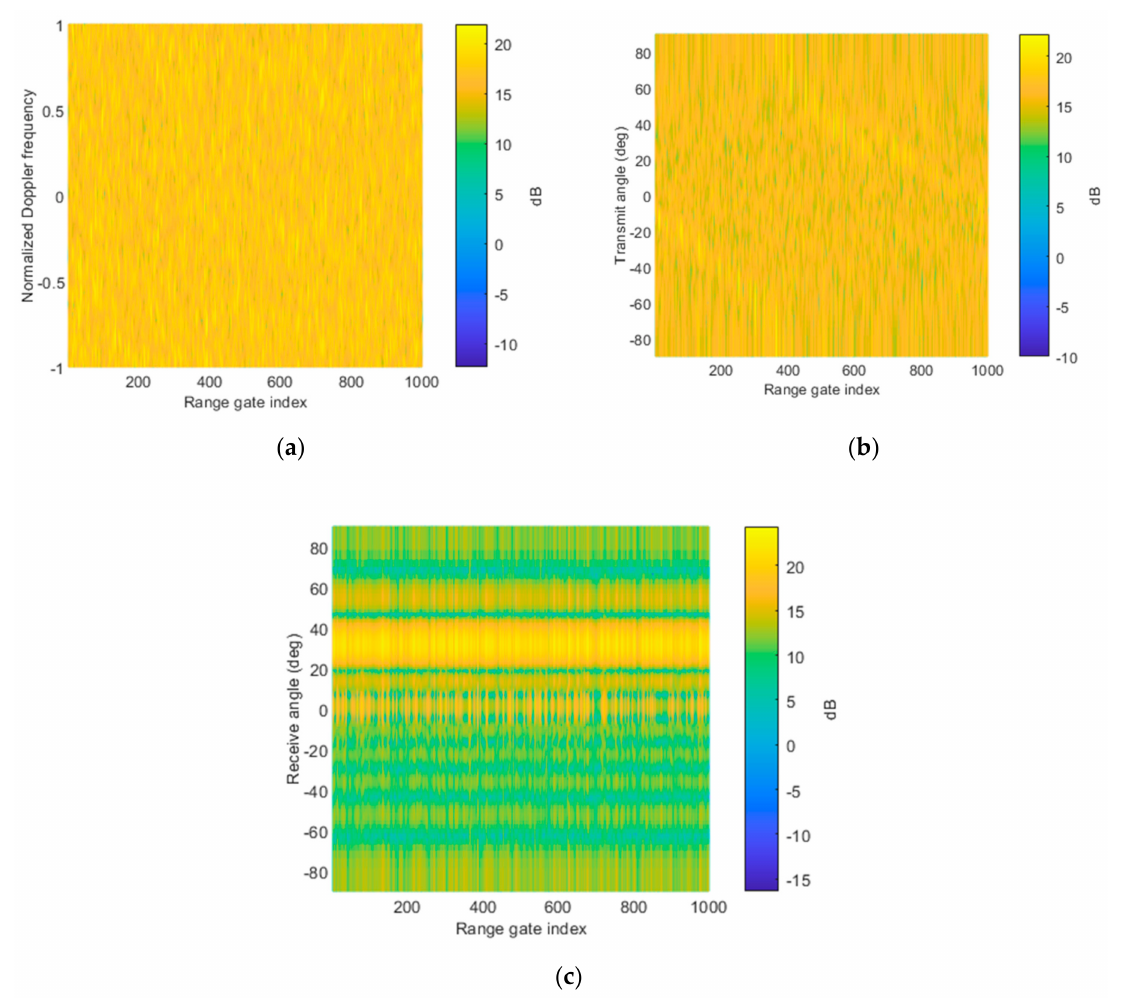
Figure 4. Fourier power spectrum of receive signal, including the true target, suppressive jamming, and RGPO false targets in the ( a ) normalized Doppler frequency and range dimensions; ( b ) transmit spatial angle and range dimensions; and ( c ) receive spatial angle and range